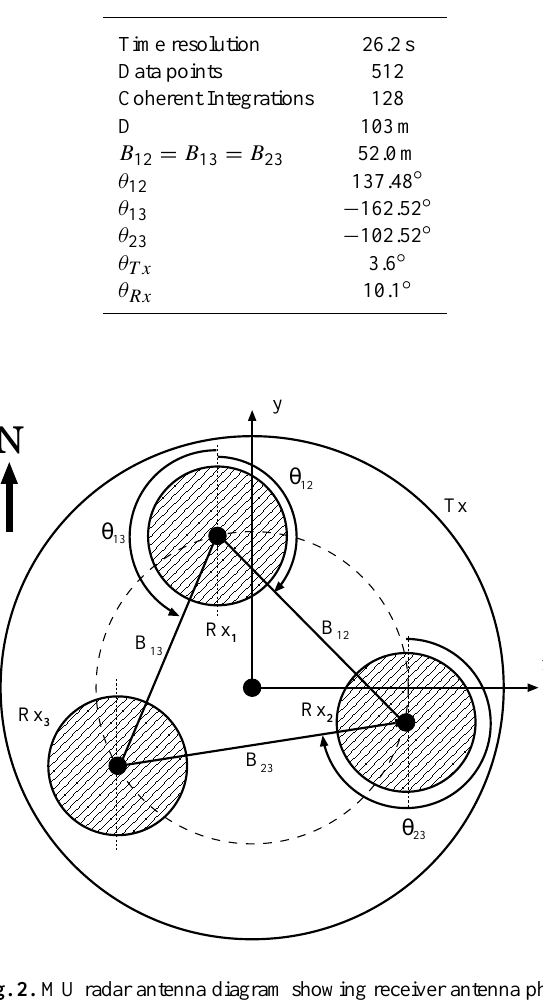
Fig. 2. MU radar antenna diagram showing receiver antenna phase centers located equi-distant from the transmitter antenna phase cen- ter.